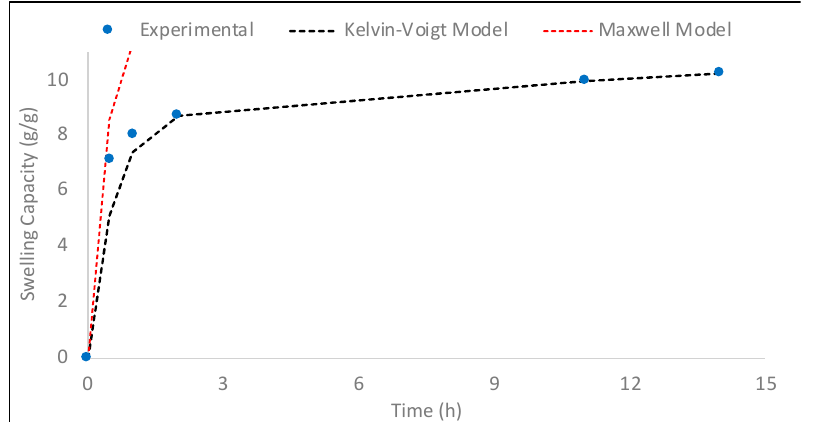
Figure 5. Fitting of experimental swelling capacity data with known model for viscoelastic polymeric materials. Conditions: 6.2 mg and thickness of 0.05 mm of hydrogel, 5 mL buffered solution at pH 4.0, and T = 22 °C.